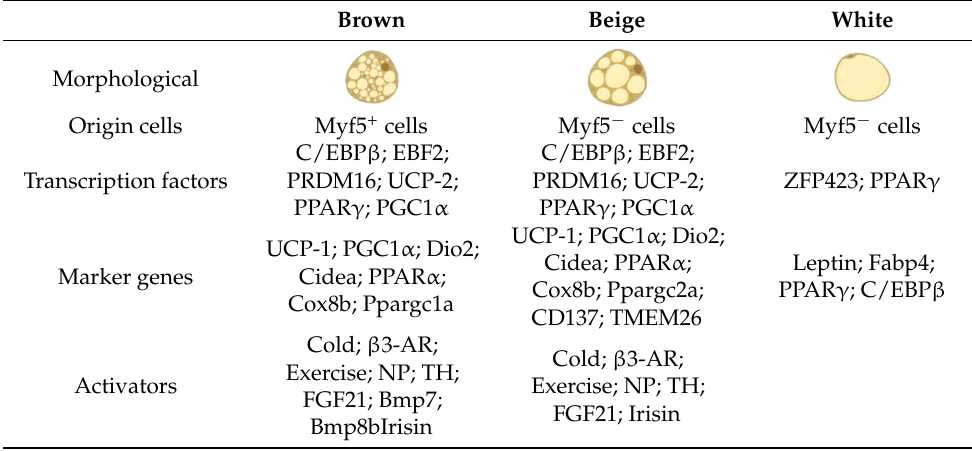
Table 1. Characteristics of brown, beige, and white fat cells. Brown Morphological